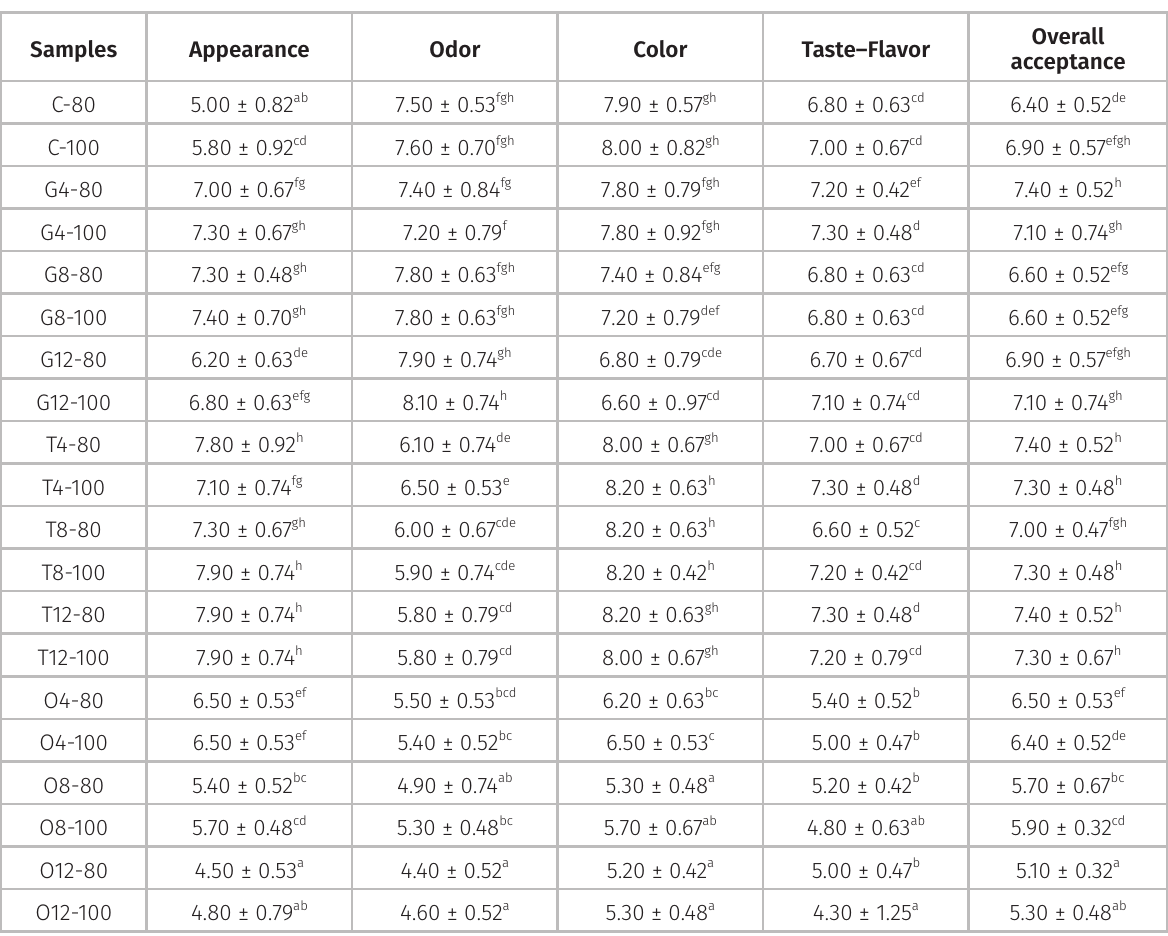
Table V. Sensorial properties of the noodles.